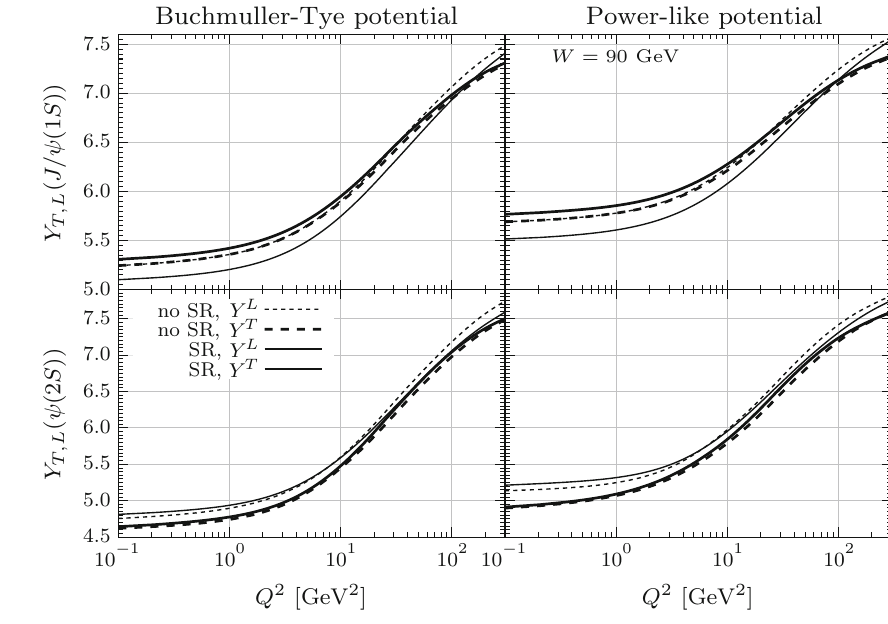
Buchmuller-Tye potential Power-like